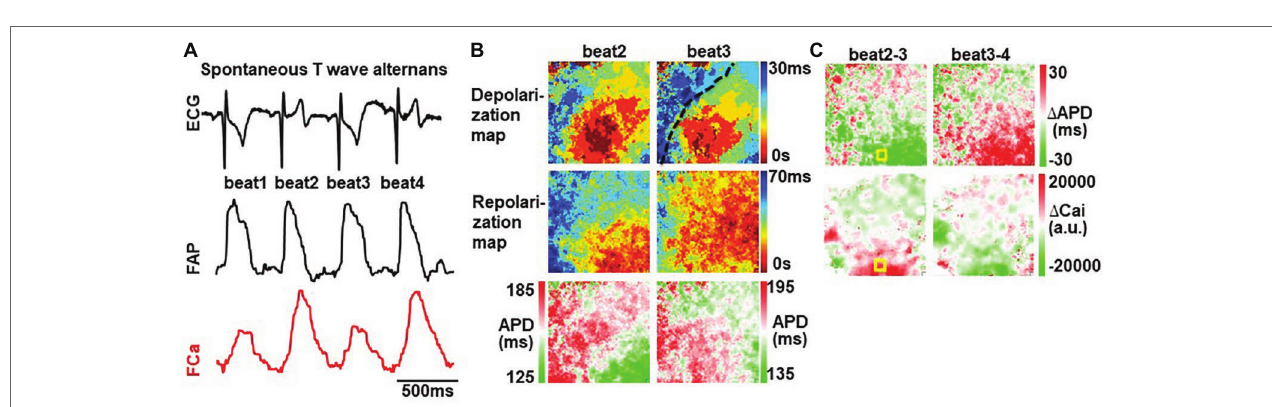
FIGURE 6 | Spontaneous NS5806-induced alternans is AP/Ca and spatially discordant. (A) ECG of spontaneous T-wave alternans ( top ), long-short-long-short APD alternans ( mid ), and small-large-small-large Ca transient amplitude alternans ( bottom ). (B) Depolarization isochronal maps show a minor alternation in propagation velocity (particularly towards the RV), but the repolarization sequence was dramatically different in alternating beats. Dotted line marks location of left anterior descending artery. (C) Alternans maps show AP/Ca and spatial